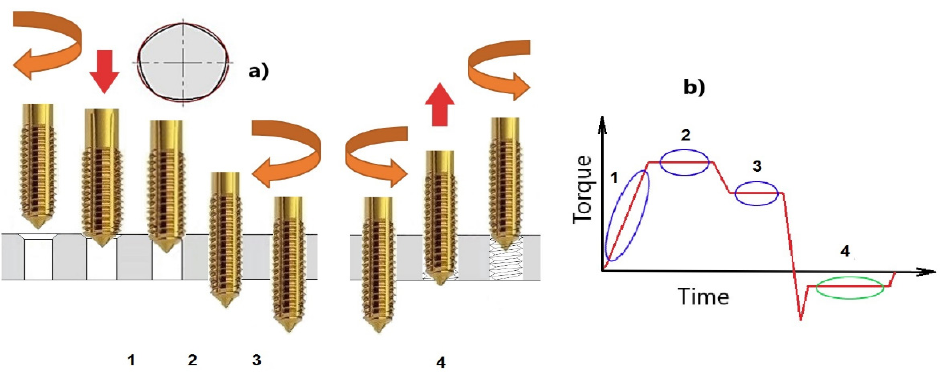
Figure 6. Development of the cross-section (area) of material to be converted into the thread. The whole process of thread forming, with highlighting of some critical time periods, can be seen in Figure 7.